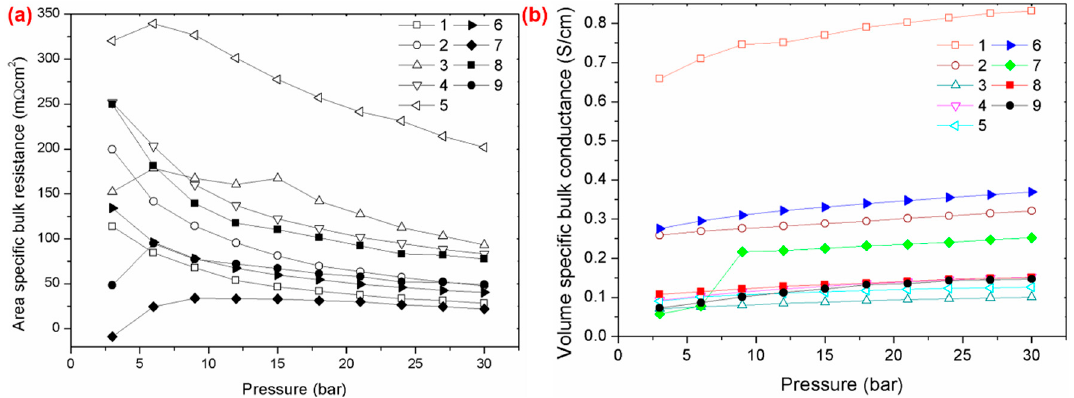
Figure5. ( a )Areaspecificbulkand( b )VolumespecificbulkconductanceresistanceofPP / MCF / xGNP / SG Figure 5. ( a ) Area specific bulk and ( b ) Volume specific bulk conductance resistance of composite at di ff erent PP/MCF/xGNP/SG composite at different pressures.